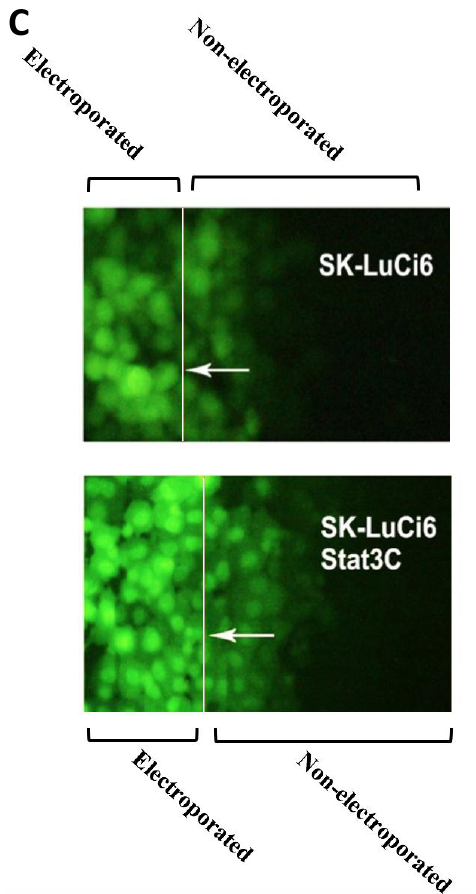
Figure 3. ( A ) Stat3 downregulation eliminates gap junctional permeability in human lung carcinoma QU-DB cells. LY was electroporated into QU-DB cells following treatment with the DMSO carrier alone (a–c), or the Stat3 inhibitor CPA7 (d–f). Cells from the same field were photographed under fluorescence (b,e) or phase contrast (a,d) illumination. Cells at the edge of the conductive area which were